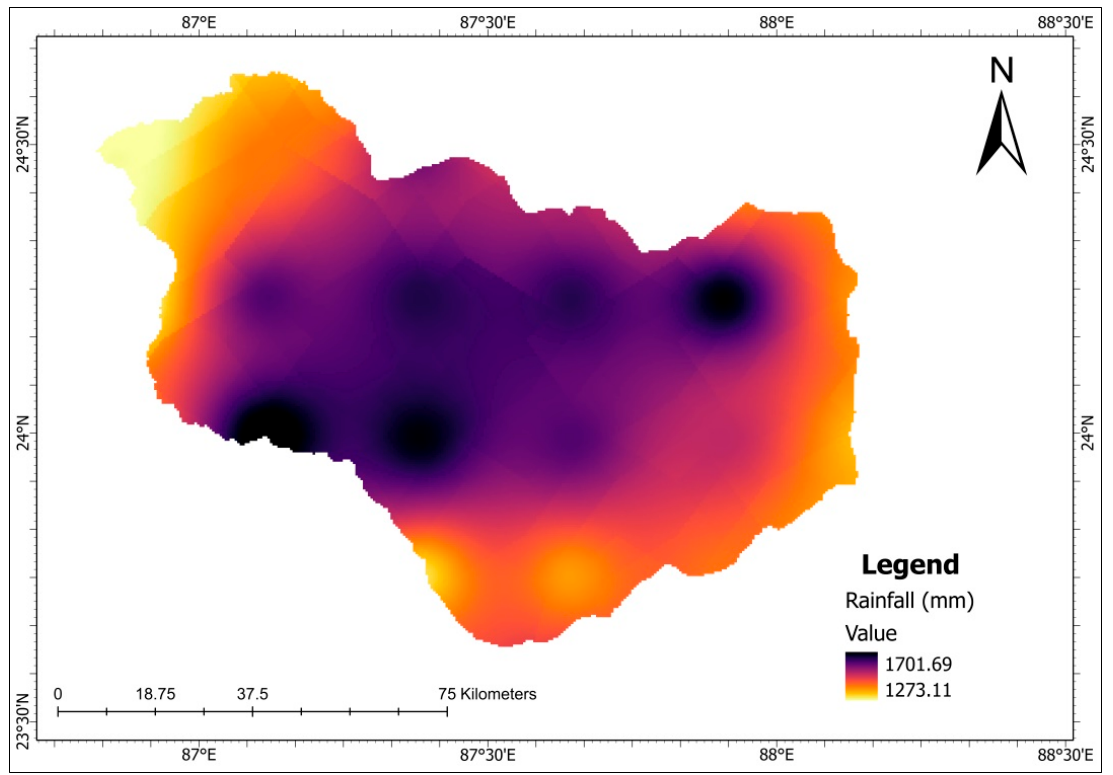
Figure 4. Rainfall map of study area.